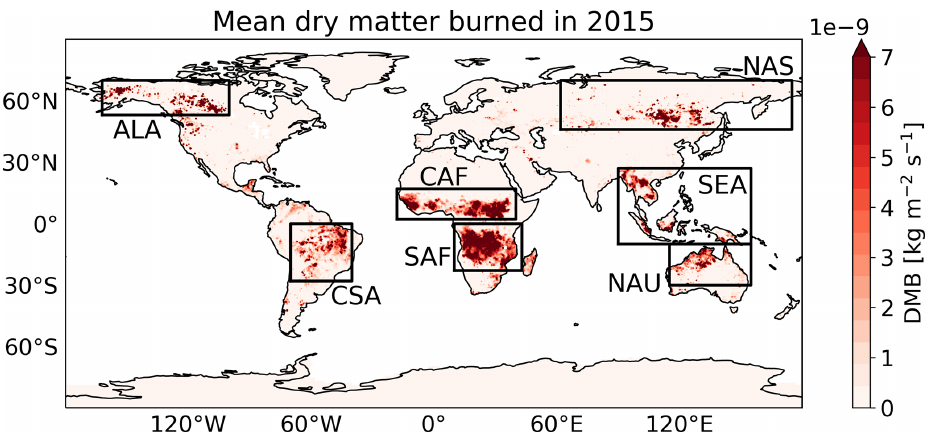
Figure 2. Mean dry matter burned (DMB) in 2015. The naming of each region is as follows: Alaska (ALA), central Africa (CAF), central South America (CSA), northern Asia (NAS), northern Australia (NAU), southern Africa (SAF), and South East Asia (SEA). Further details about each region are presented in Table 2. Table 2. Characteristics of the different biomass burning regions focusing on the dominant fuel type, the main biomass burning season, and the dry matter burned (DMB). The global DMB by GFAS (Kaiser et al., 2012) for the year 2015 is 4985Tga − 1 . The naming of each region is as follows: Alaska (ALA), central Africa (CAF), central South America (CSA), northern Asia (NAS), northern Australia (NAU), southern Africa (SAF), and South East Asia (SEA). Each region is graphically illustrated in Fig. 2. Region Dominant fuel type Main biomass 2015 burning season DMB [Tga − 1 ] ALA Extratropical forest with organic soil JJA 295 CAF Tropical forest and savanna DJF 778 CSA Savanna SON 439 NAS Extratropical forest with organic soil MMA and JJA 363 NAU Savanna SON 260 SAF Tropical forest and savanna JJA 1036 SEA Tropical forest a SON 1237